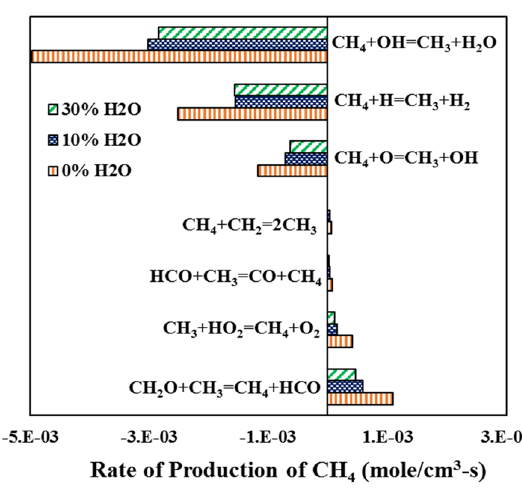
Figure 8. Rate of methane production for various steam dilution (0%, 10%, and 30%) conditions at 1.6 atm and 1800 K using Aramco